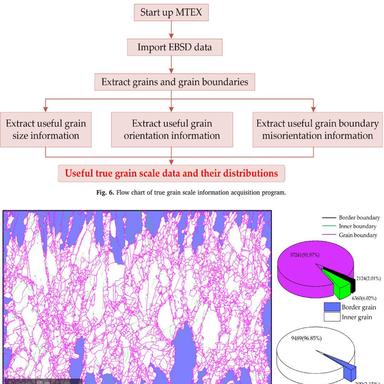
Extracted grains and boundaries and relevant comparisons.